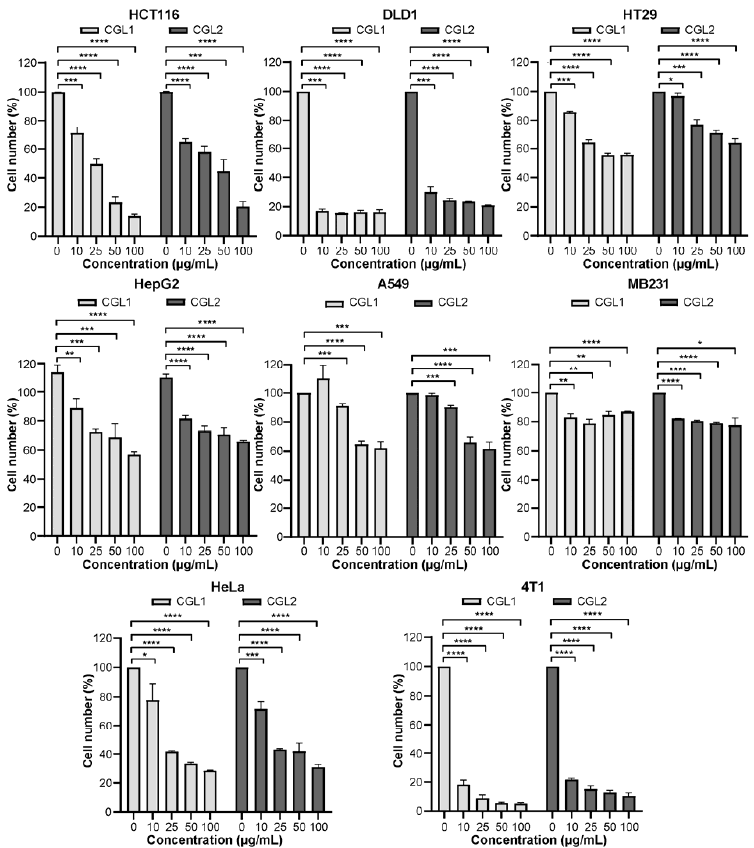
when treated with 10 µ g/mL galectins ( IC 50 < 1 µ M). The IC 50 values of CGL1 and CGL2 on HCT116 cells were 22.13 µ g/mL (1.35 µ M) and 29.09 µ g/mL (1.77 µ M), respectively. On the other hand, CGL1 and CGL2 also showed cytotoxicity on two normal cells, HL7702 and NIH-3T3, but with higher IC 50 values than DLD1 and HCT116 (Figure S3). Further PI/Calcein-AM staining demonstrated that after 16 h incubation with 100 µ g/mL CGL1 or CGL2, nearly all HCT116 cells died (Figure S4). These results suggested that CGL1 and CGL2 can induce human cancer cell death, including different types of human colorectal cancer cells.